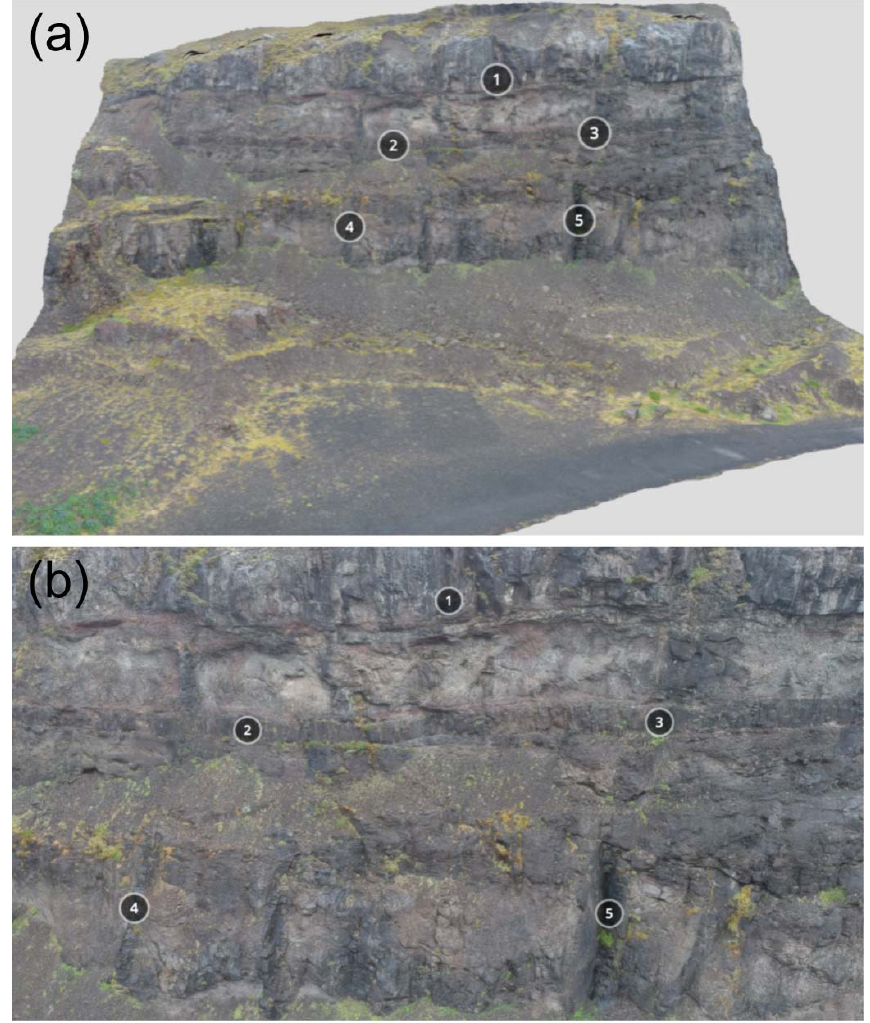
Figure 13. ( a ) Overall view of the 3D model. Numbers are interactive annotations that can be clicked online, providing the viewer with explanations about particularly relevant features; ( b ) detail of the vertical cliff, showing the horizontal lava bedding on top, as well as a number of dykes (examples at annotations 4 and 5). The crosscutting relationship (annotation 3) between the sill and the dyke clearly shows that the sill was emplaced later than the dyke.